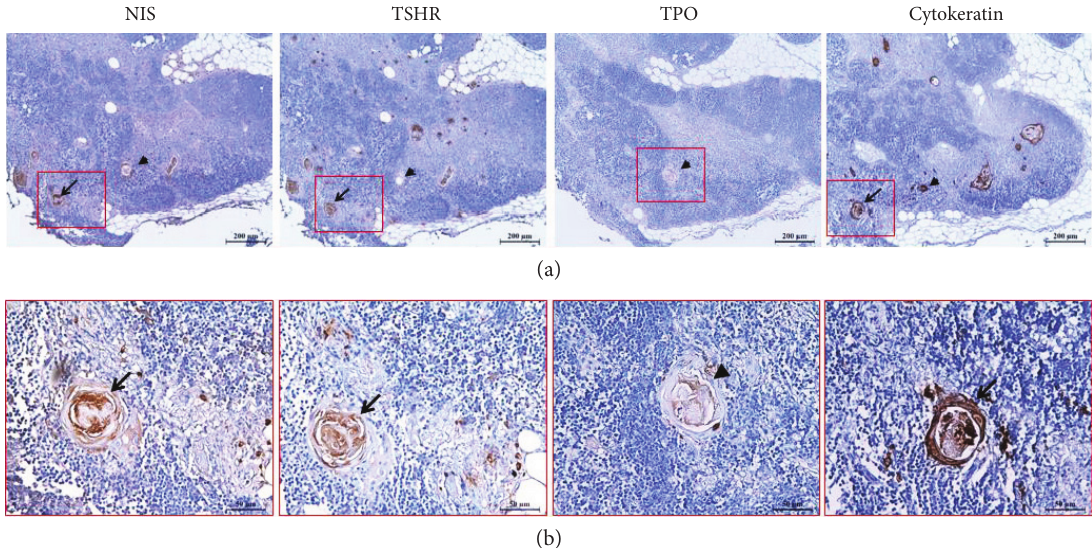
Figure 3: Localization of NIS, TSHR, and TPO in the thymus. The expression of NIS, TSHR, and TPO is localized to the Hassall ’ s corpuscles (arrows and arrowheads) that are positively stained with cytokeratin. The low (a) and high (b) magni fi cations of the images are 100x and 400x, respectively. The scale bars represent 200 μ m (a) and 50 μ m (b). NIS, sodium iodide symporter; TSHR, thyroid-stimulating hormone receptor; TPO, thyroid peroxidase.